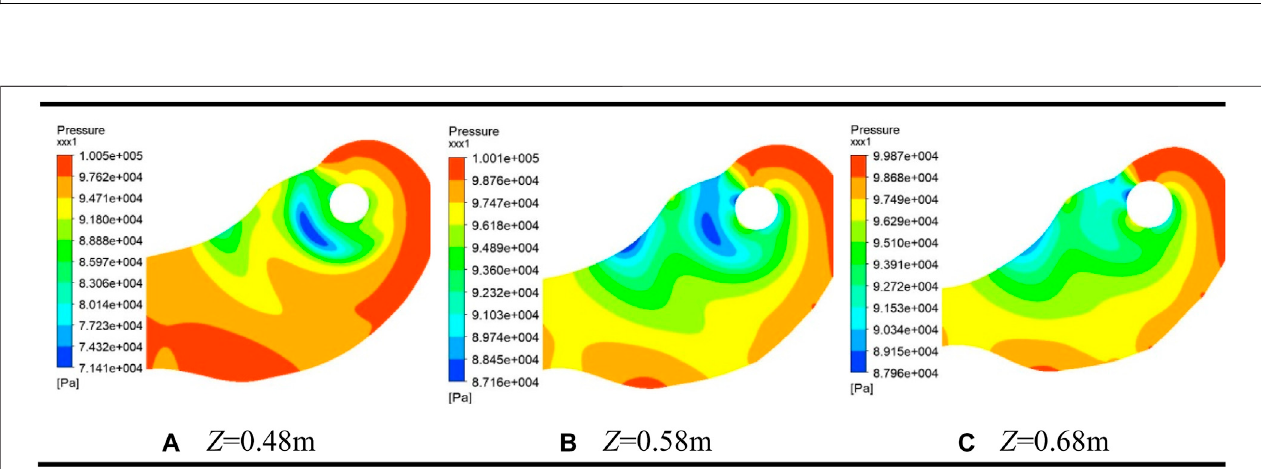
FIGURE 5 | Cross-sectional pressure diagram of the suction chamber at Q = 4.0 m 3 /s. Z in represents different cross-sectional heights.